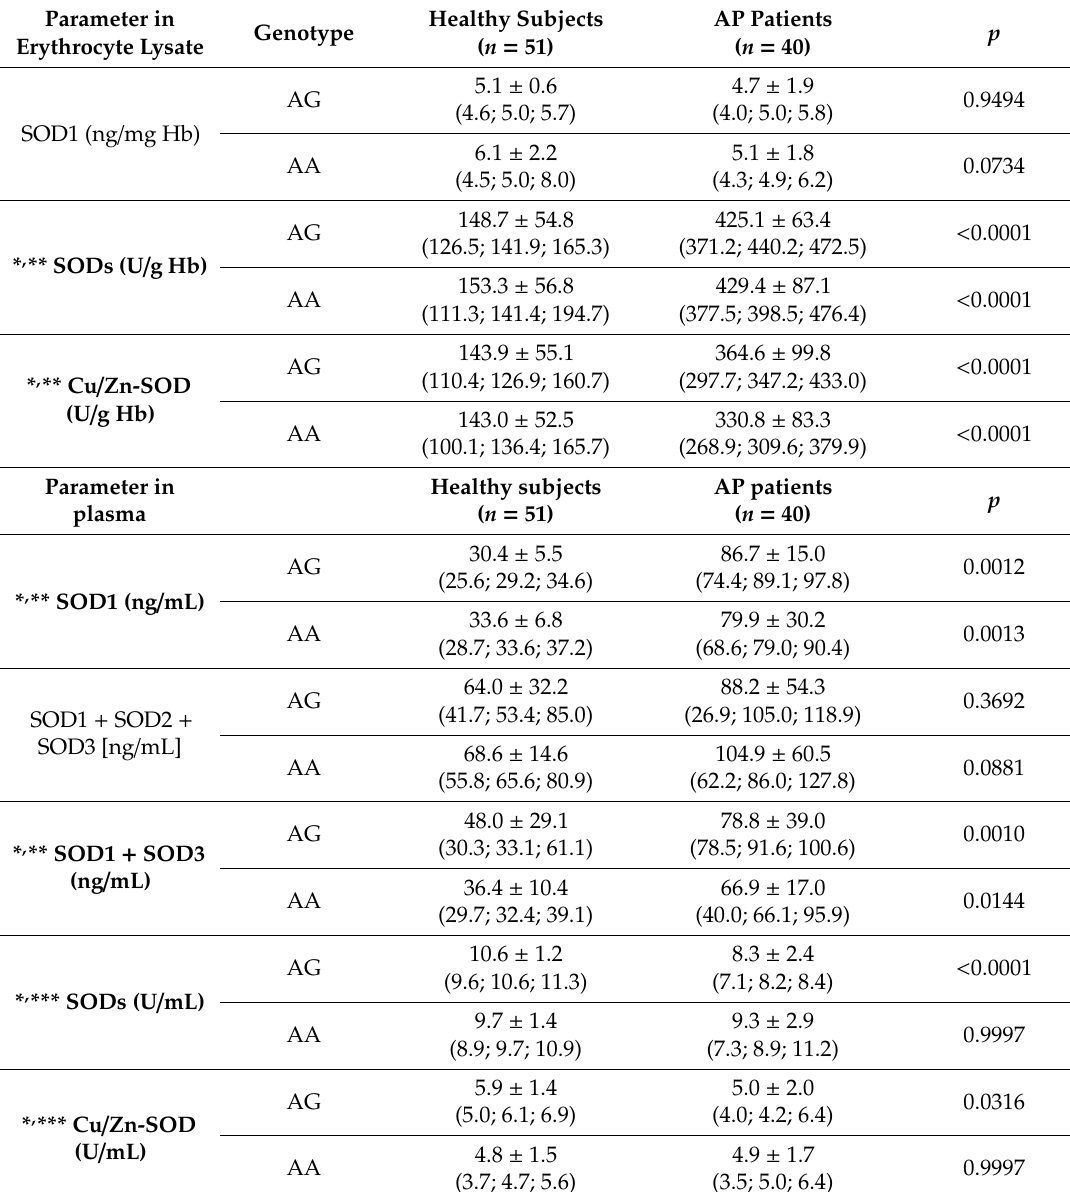
Table 4. Concentration and Activities of SODs Isoenzymes, Concentrations of Metals (Cu, Zn), Markers of Inflammation and Oxidative Stress in the Group of Healthy Subjects and AP Patients Divided in Terms of Genotype for SNP rs2070424 in SOD1 Gene (NCBI Reference Sequence: